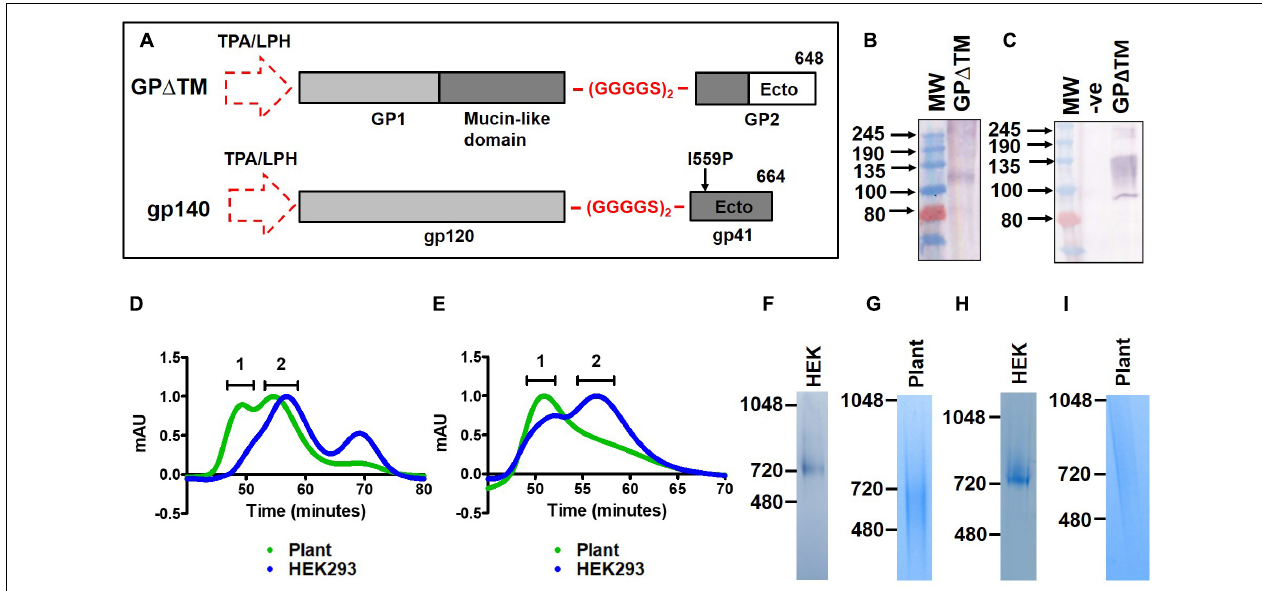
FIGURE 1 | Design and purification of recombinant viral glycoproteins in plants. (A) Schematic of the synthetic MARV GP (cid:49) TM (top) and HIV Env gp140 (bottom) antigen sequences. The natural signal peptide was replaced with the LPH or TPA leader peptides (dotted arrow) for expression in plants and mammalian cells respectively. A flexible linker peptide, (GGGGS) 2 , was inserted in place of the furin cleavage site and the transmembrane and cytoplasmic domains of the proteins were removed. The location of the GP 1 and GP 2 subunits, and the mucin-like domain are indicated for MARV GP (cid:49) TM. The gp120 and gp41 subunits are similarly shown for HIV Env gp140. A stabilizing isoleucine to proline mutation was also included in the HIV Env gp140 antigen (I559P). The amino acids where the proteins were truncated are indicated as 648 and 664 for MARV and HIV, respectively. (B) Western blotting of plant homogenate to detect expression of recombinant MARV GP (cid:49) TM. (C) Western blotting to detect expression of MARV GP (cid:49) TM in transfected mammalian cell lysate. In both panels (B,C) , the recombinant protein was detected using a polyclonal rabbit antibody raised against a synthetic peptide from the glycoprotein. (D,E) Overlayed S200 elution profiles of recombinant plant-produced and mammalian cell-derived HIV Env gp140 NFL and MARV GP (cid:49) TM, respectively. The plant-produced protein is shown in green whereas the mammalian cell-derived protein is indicated in blue. 1 = aggregate peak, 2 = putative trimer peak. Coomassie-stained BN-PAGE gels for the pooled trimer fractions are shown in panels (F–I) for mammalian cell-produced HIV Env gp140 (HEK), plant-plant produced gp140 (plant), mammalian cell-derived MARV GP (cid:49) TM and plant-produced MARV GP (cid:49) TM, respectively. (-ve = untransfected cell lysate, Ecto = Ectodomain, TM = transmembrane region, CT = cytoplasmic